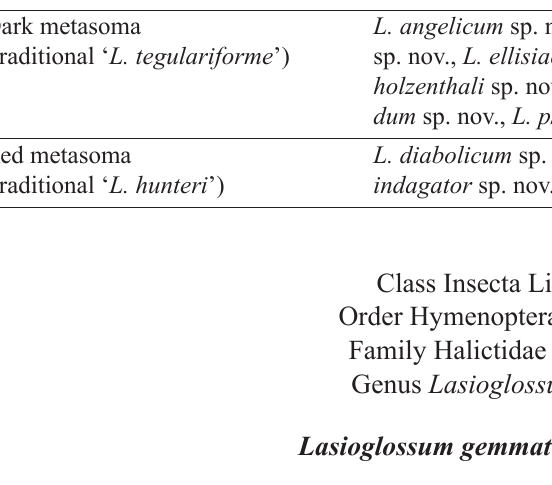
Table 1. Currently recognised species in the L. gemmatum species complex of the western Nearctic region, according to metasoma colour and which species each would have most likely been determined as prior to